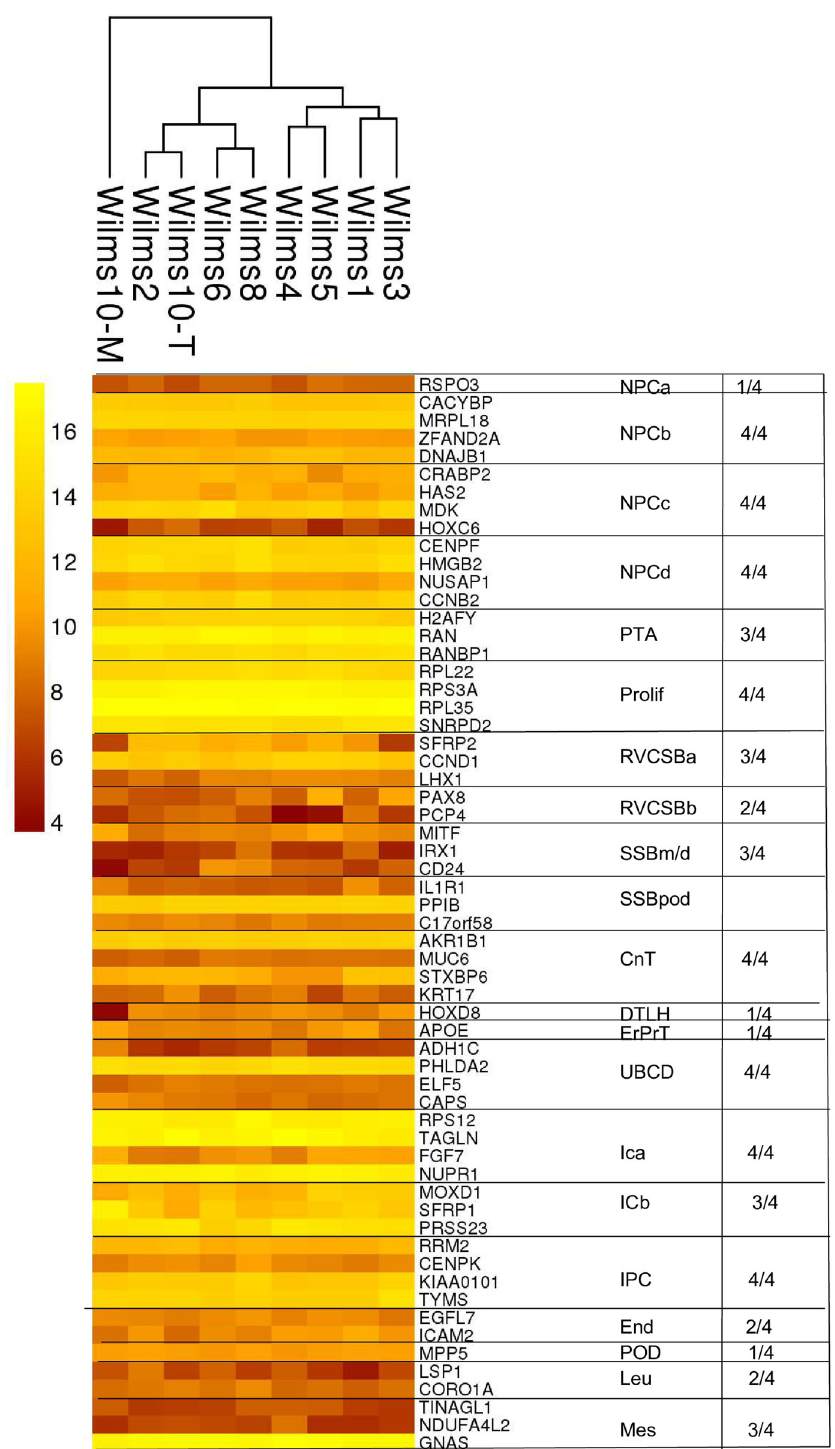
Fig 7. Expression of the TOP 4 genes from the marker set candidates in the Wilms cell lines. In the heat map the expressed genes from the top 4 genes are shown ( > 200).